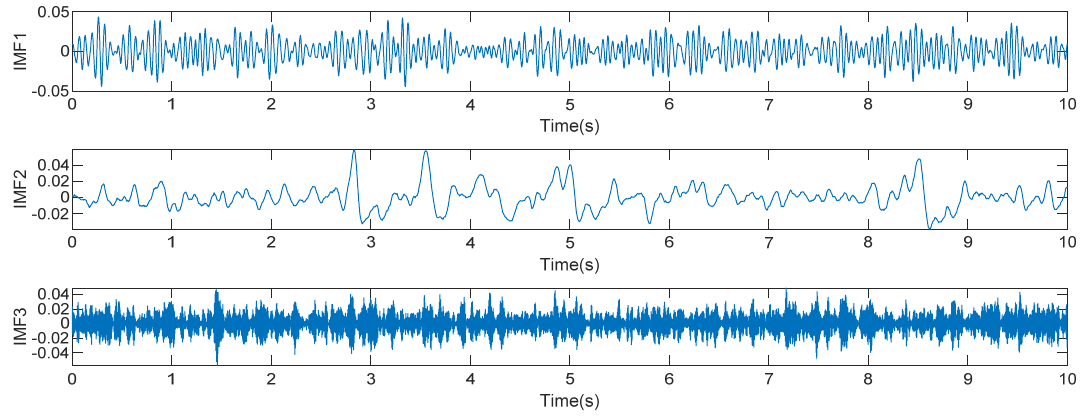
Figure 3. Original artifact containing signal and signal components after VMD-SOBI method.